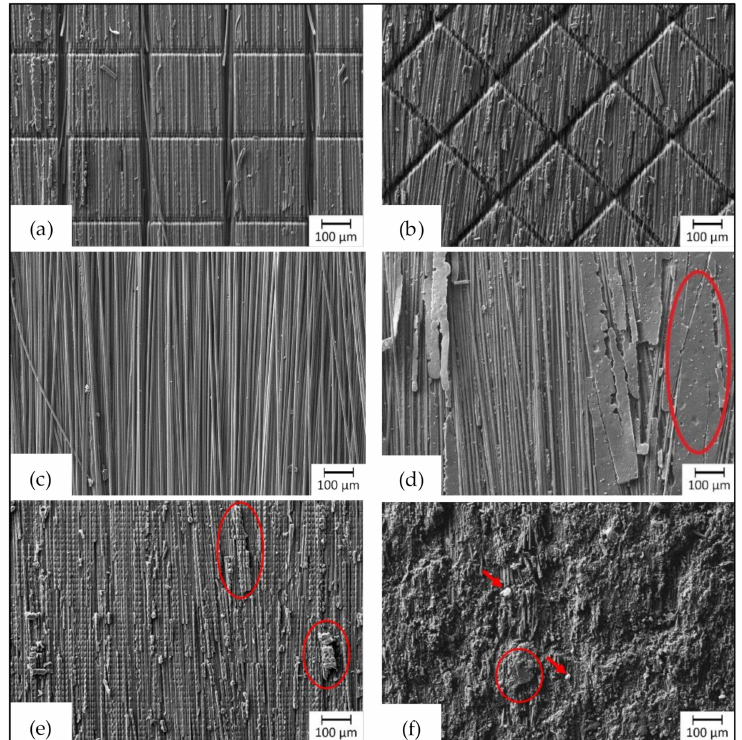
Figure 3. SEM images of pre-treated CFRP substrates: ( a ) R+GS_300_70, ( b ) R+GS_ ± 45_300_70, ( c ) CO2_SMR, ( d ) USP_SMR, ( e ) laser roughening, and ( f ) grit blasting. Red ellipses highlight matrix residues and red arrows mark corundum